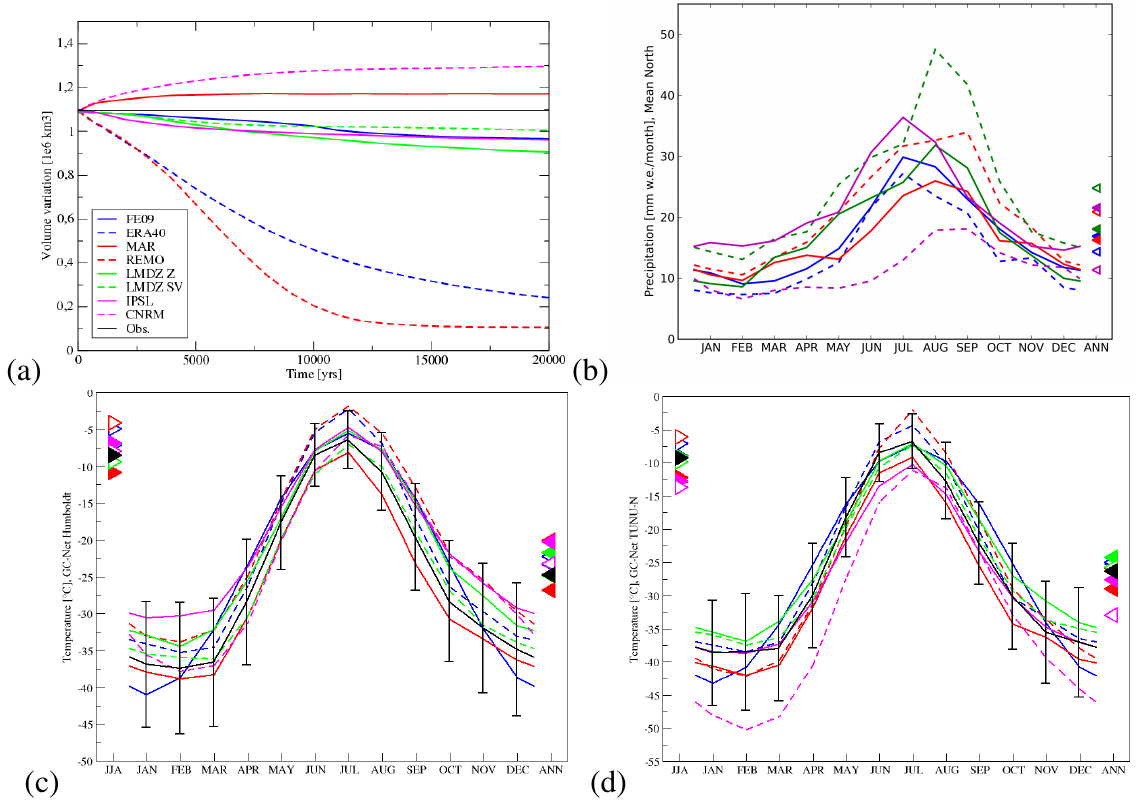
Fig. 6. (a) : North Greenland (latitudes greater than 75 ◦ N) simulated ice volume evolution for the steady state model runs shown in Fig. 5. The regional initial volume corresponds to the observed one. (b) : Regional (land mask with latitudes greater than 75 ◦ N) monthly mean precipitation for each individual atmospheric forcing, with annual mean values (triangles). (c, d) : Station climatology for, respectively, Humboldt and Tunu-N (Steffen et al., 1996), and closest grid point near surface air temperature for each individual atmospheric forcing, with July temperature (left hand triangles) and annual mean temperature (right hand triangles). The black markers stand for the observations (initial regional ice volume and t2m stations measurement). Vertical bars are standard deviations from the monthly mean in the observations datasets. Time periods vary, depending on availability. 44